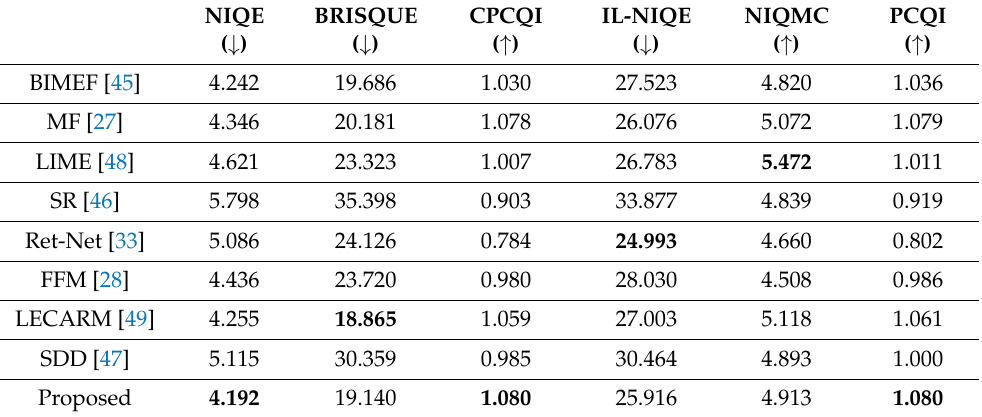
Table 1. Average value of six quantitative metrics of 104 images under different algorithms. NIQE BRISQUE ( ↓ ) ( ↓